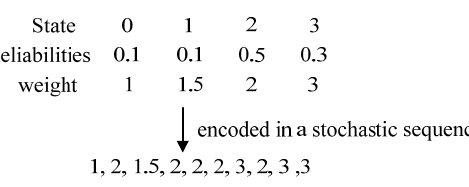
Figure 3. The stochastic encoding of the weights and reliabilities of component i using a multi-valued sequence with sequence length L = 10.